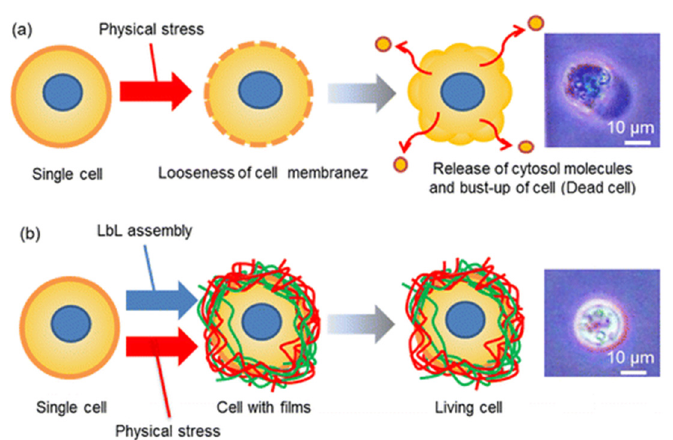
Figure 13. Schematic representation of the positive effect of LbL films on the stability of cells against physical stresses: ( a ) effect of physical stresses on a nude cell and ( b ) effect of physical stresses on a LbL coated cell. Reprinted with permission from reference [315]. Copyright (2013), with permission from American Chemical Society.